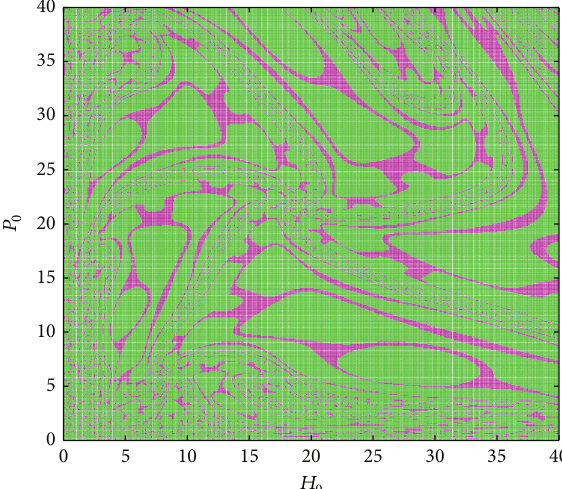
Figure 9: The basins of attraction of model (4) for two attractors shown in Figure 7. The parameter values are as follows: 𝑇 = 10 , 𝑇 ℎ = 0.5 , 𝐾 = 50 , 𝛿 = 0.3 , 𝛾 = 1 , 𝛼 = 0.01 , 𝜃 = 0 , 𝑞 = 0.05 , and 𝑟 = 3.2 .